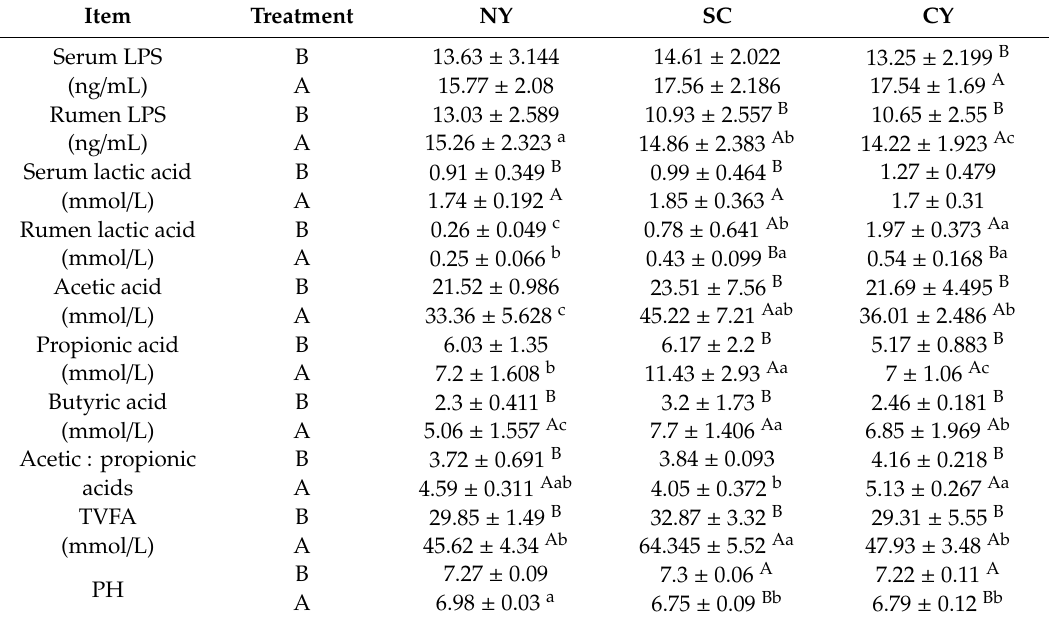
Table 2. Fluid characteristics before and after